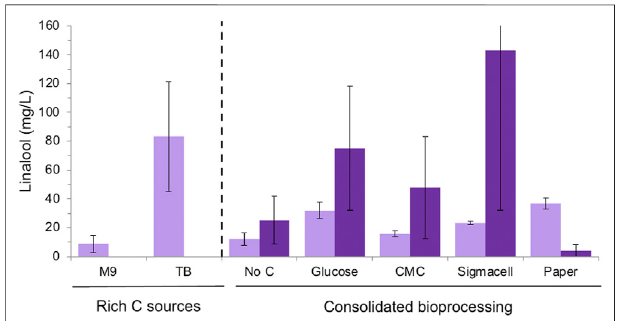
FIGURE 5 | Linalool production of E. coli DH5 α and BL21 (DE3) strains expressing pMVA-GLinS NR2 on cellulose-based carbon sources. Simultaneous sacchari fi cation and fermentation was performed in minimal mediumwithsupplementalthiaminefortheDH5 α strain.Glucoserelease from cellulose-based medium was performed via the addition of the cTec2 enzymeblend.Theerrorbarsrepresentonestandarddeviationsofaminimum of triplicate assays. E. coli strains: DH5 α = dark purple; BL21 = light